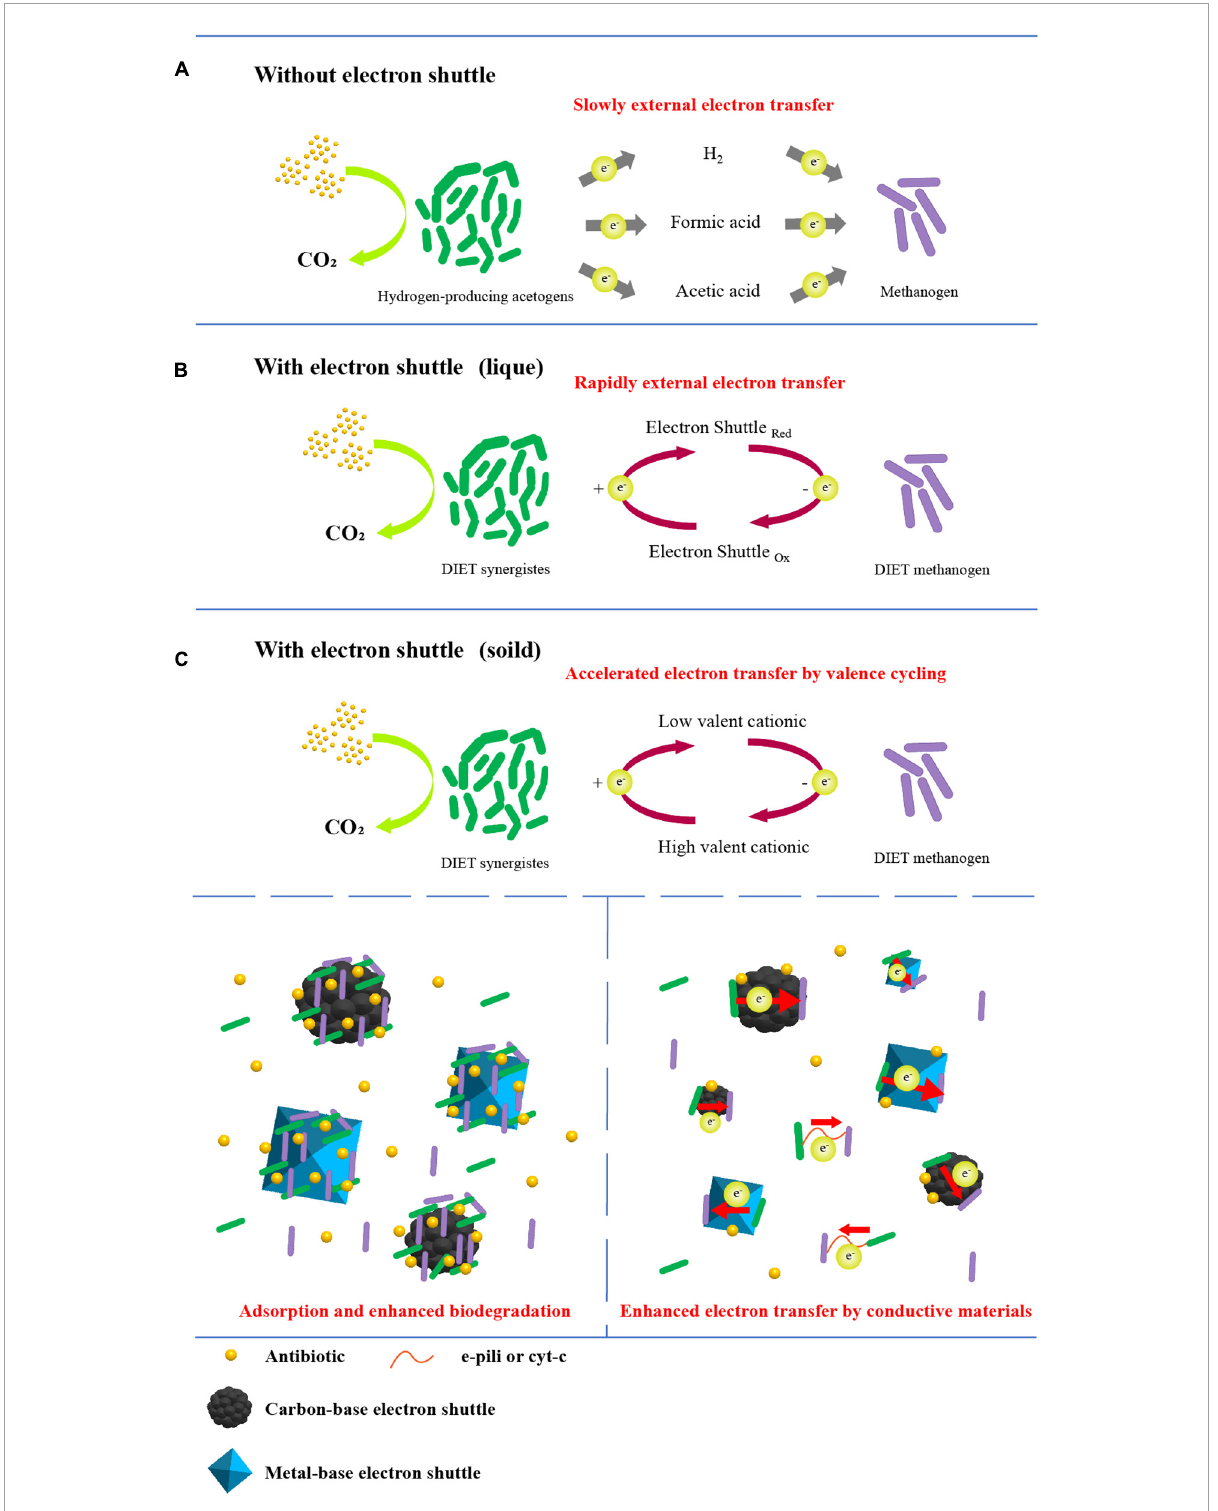
FIGURE2 Possible mechanisms of anaerobic treatment of antibiotics (A) without electron shuttle, (B) enhanced by liquid electron shuttle, (C) enhanced by solid electron shuttle.